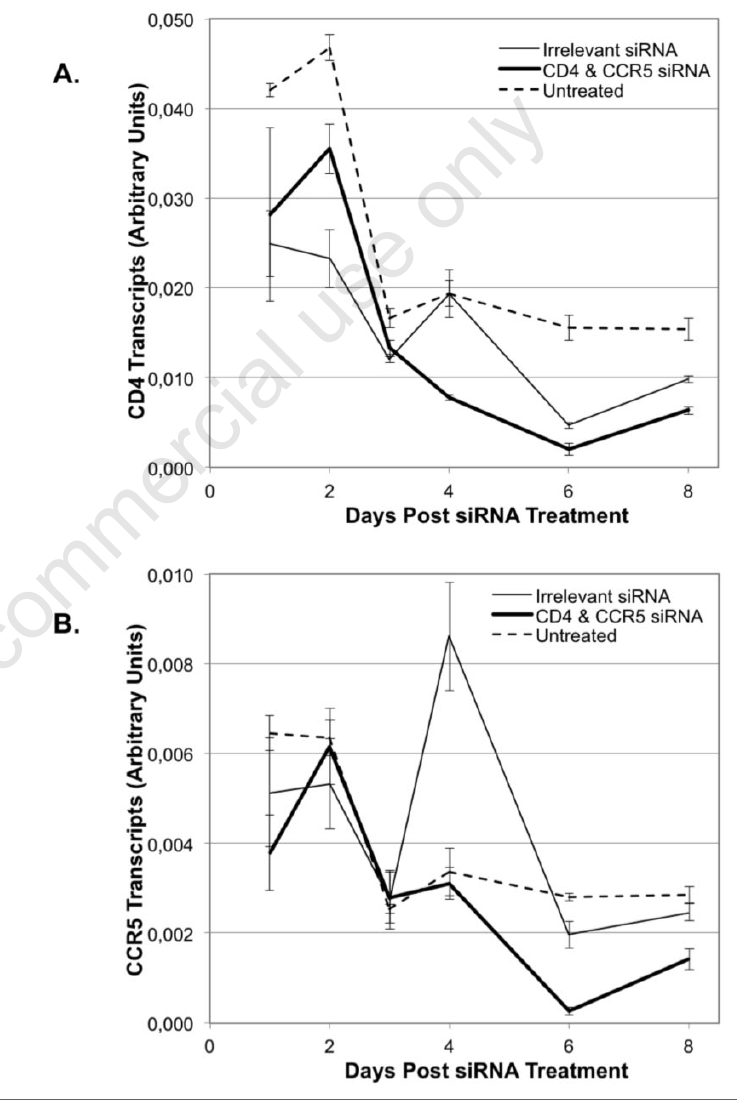
Figure 3. Timeline of siRNA effects on CD4 and CCR5 expression in human female reproductive tract ectocervical explants. Ectocervical explants were treated with siRNA nanoparticles containing irrelevant siRNA (20 nM, thin line), the combination of both CD4- and CCR5-specific siRNAs (10 nM each, heavy line), or left untreated (dashed line). On days 1, 2, 3, 4, 6 and 8 of culture, tissues were harvested and assessed for levels of CD4 transcripts (panel A, top) or CCR5 transcripts (panel B, bottom). The data is from a sin- gle representative subject and shows transcript levels in arbitrary units normalized to expression of GAPDH. Error bars show standard deviation of triplicate